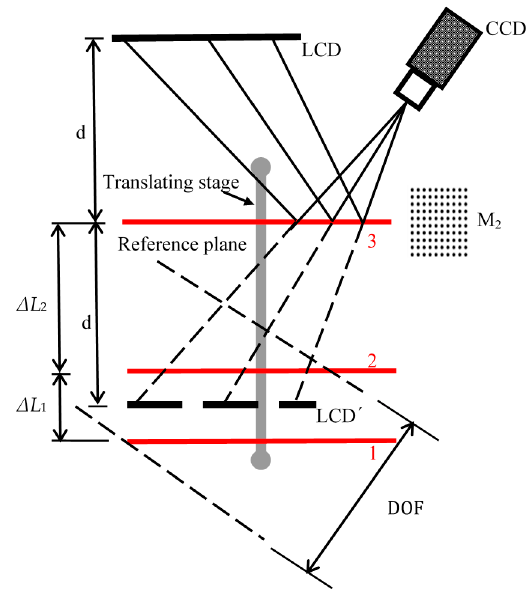
Figure 3. Schematic diagram for determining the stage movement direction and the distance d between the reference plane and the liquid crystal display (LCD)